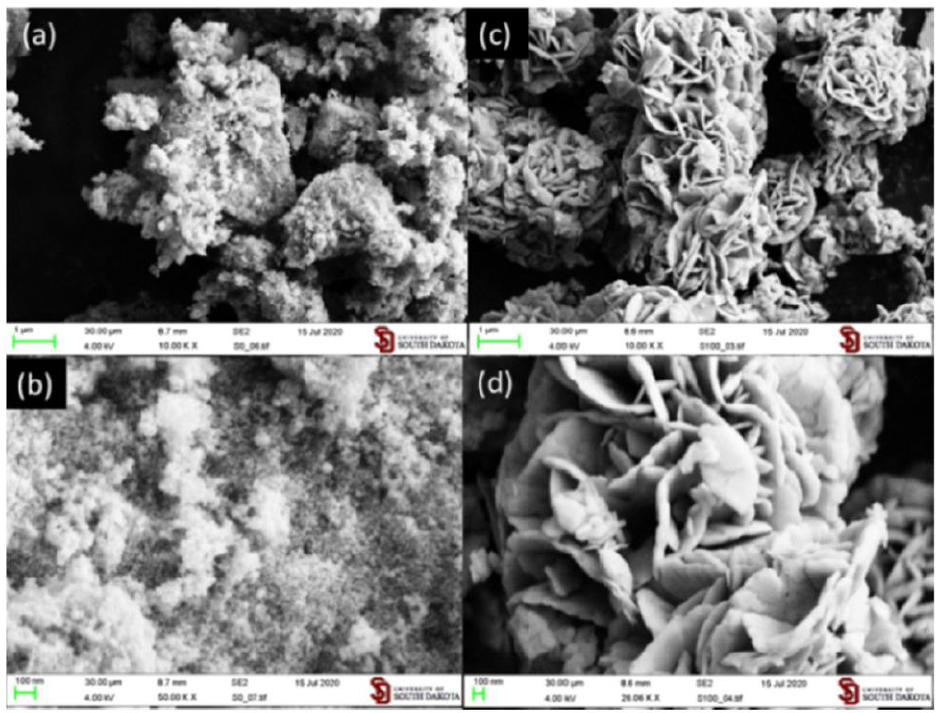
Figure 21. SEM images for ( a , b )—pure TiO 2 and ( c , d )—pure SnS 2 . Reproduced with permission from [106].